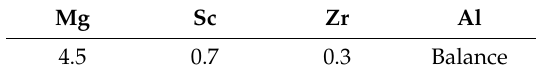
Table 1. Content (wt. %) of main alloying elements of the studied alloy.